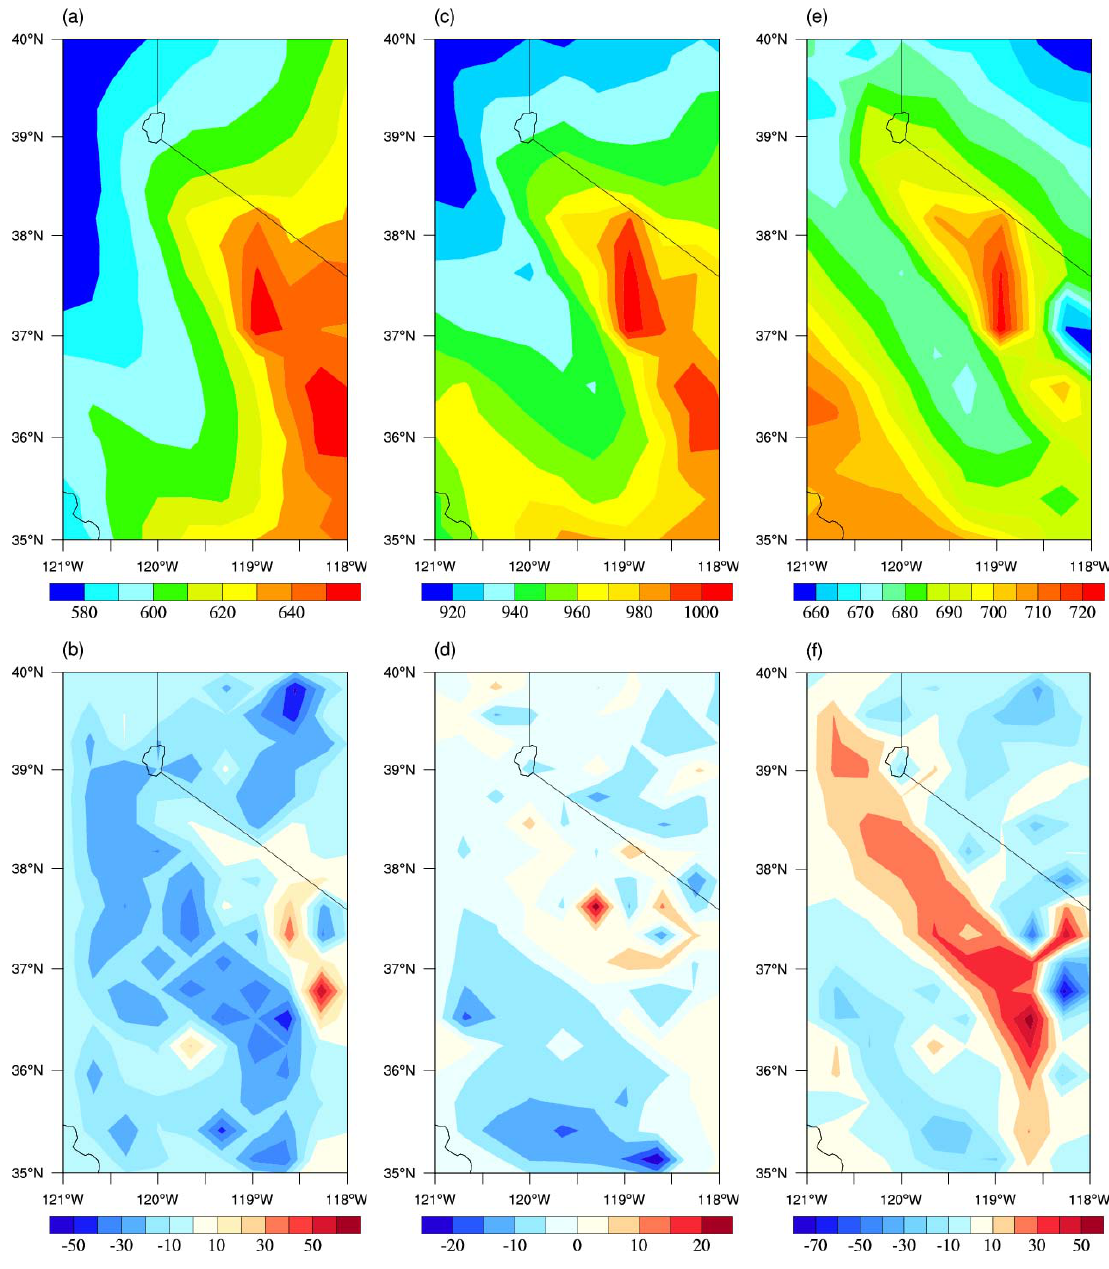
Fig. 3. Downward surface solar fluxes (W m − 2 ) over the Sierra-Nevada Mountain for a flat surface (top panel) and their deviations (bottom panel) for 9a.m. (left panel), 12p.m. (middle panel), and 3p.m. (right panel) of local time on 29 March